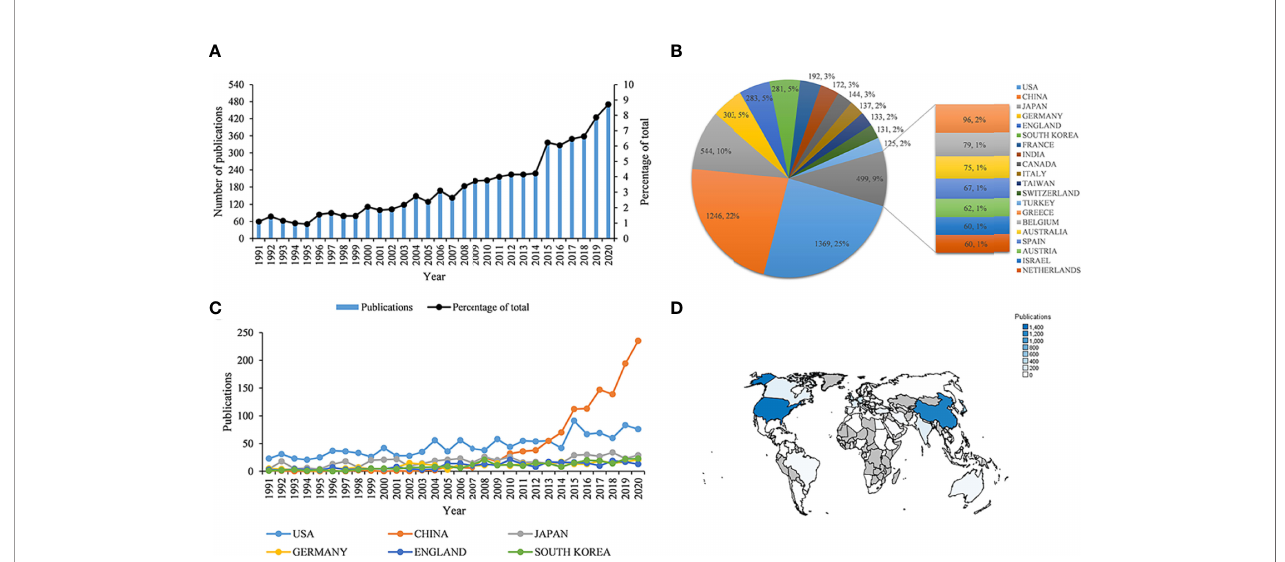
FIGURE 1 | Global trends of publications on osteonecrosis of the femoral head (ONFH) in the last 30 years. (A) Annual ONFH-related publications worldwide. (B) The total number and percentage of ONFH-related publications from the top twenty countries/regions. (C) ONFH-related publications of the top six countries/ regions over time. (D) Heatmap displaying the distribution of ONFH-related publications